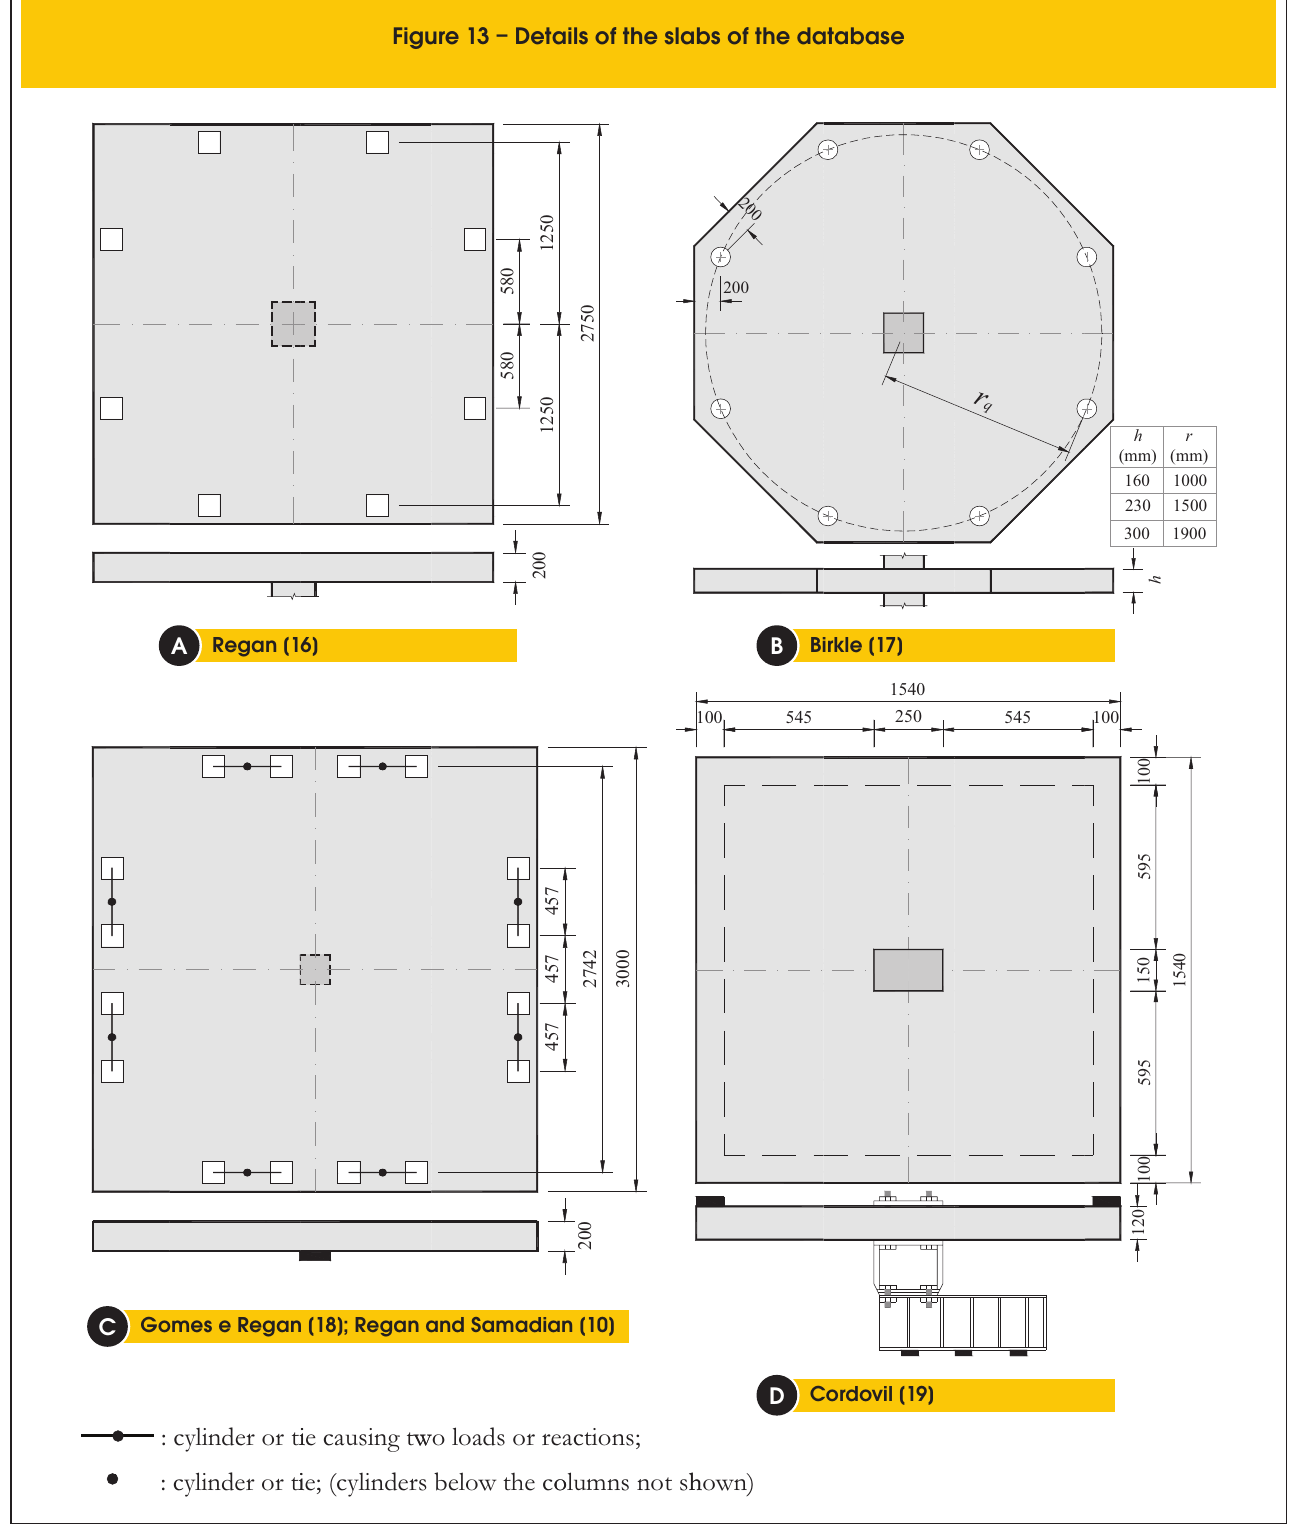
Figure 13 – Details of the slabs of the